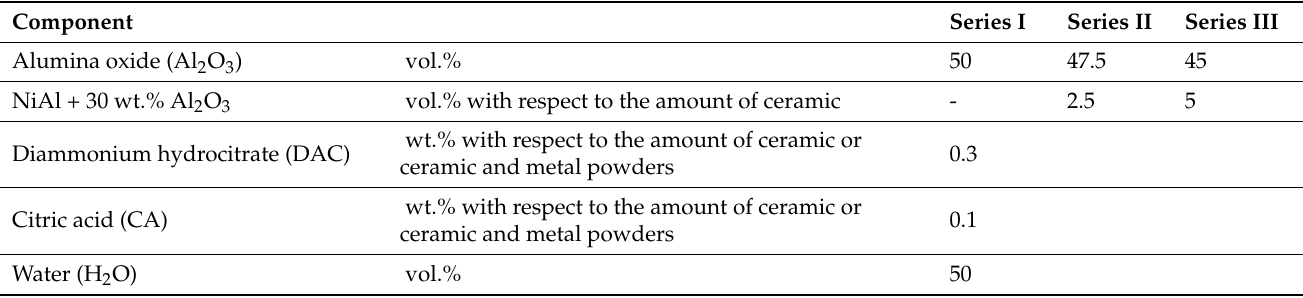
Table 1. Compositions of the prepared concentrated